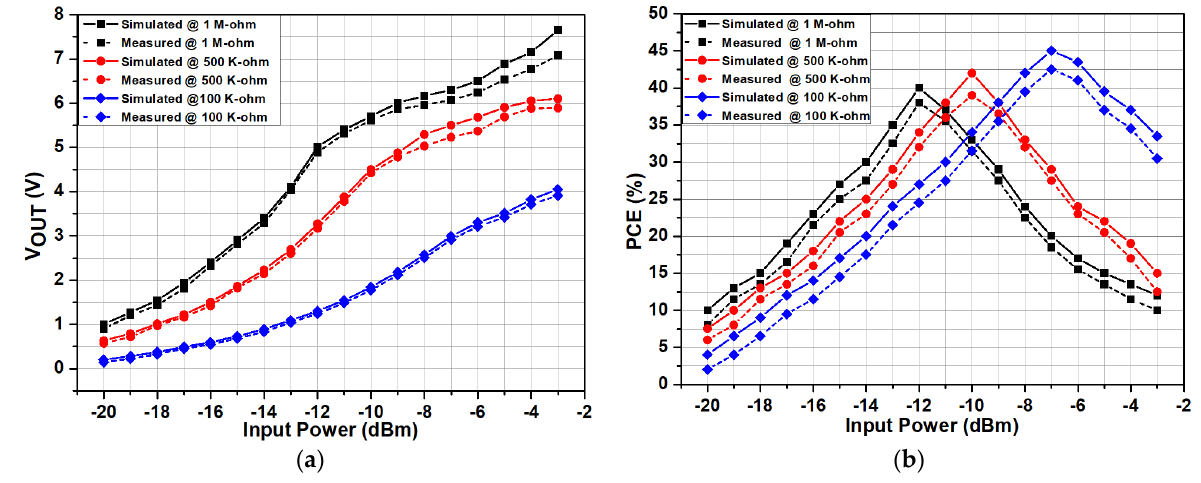
Figure 7. Simulated and measured results of the RF-DC converter for different loads. ( a ) Output DC voltage and ( b ) PCE .